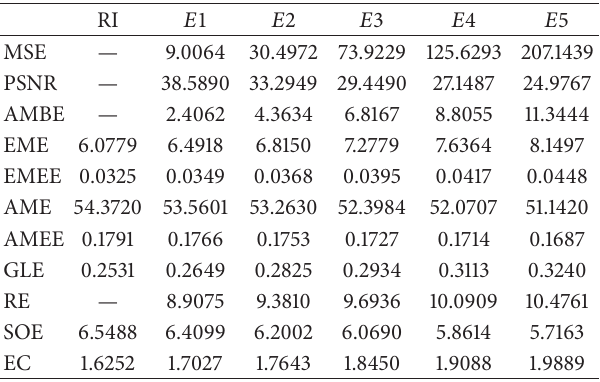
Table 4: Illustration for calculation of